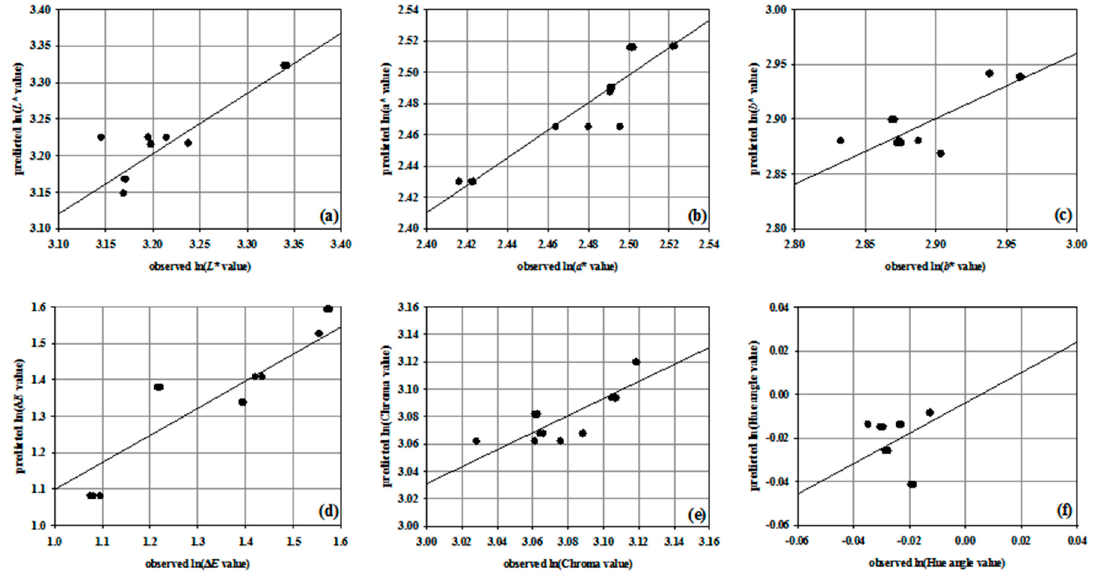
Figure 6. Linear regression models for description of colour components change during storage of L1KMK estimated using Statistica 10.0.: ( a ) L *, ( b ) a *, ( c ) b *, ( d ) Δ E , ( e ) Chroma, ( f ) Hue angle ( R 2 = 0.825, 0.937, 0.774, 0.457, 0.622, 0.696). Table 8. Linear regression models coefficients for description of colour component change during storage of V1KMK ( α = 95%) estimated using the Eureqa Formulize.